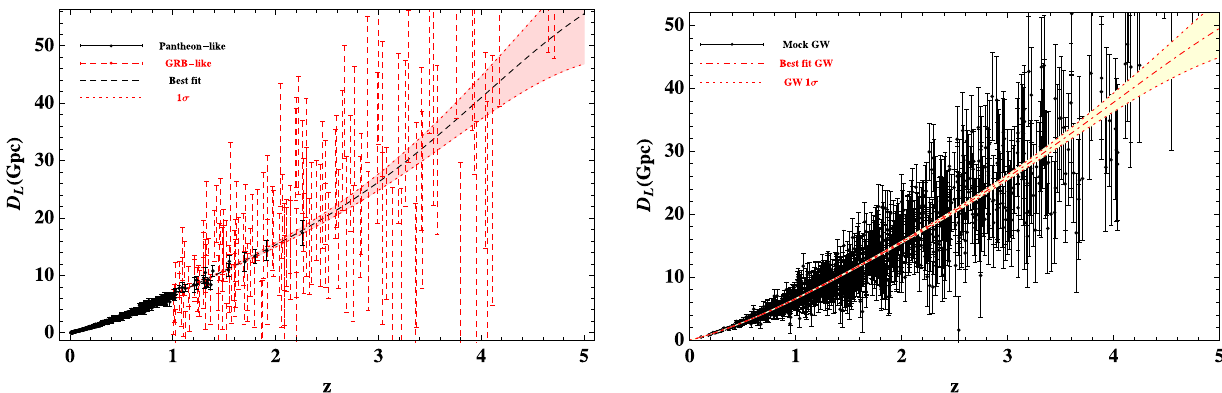
Fig. 1 The sample catalogs of the ‘pantheon-like’ data and ‘GRBs-like’ data (left panel) , and 1000 mock GW events of redshifts (right panel). The corresponding smoothed function of LD obtained from the Gaussian process method is also presented